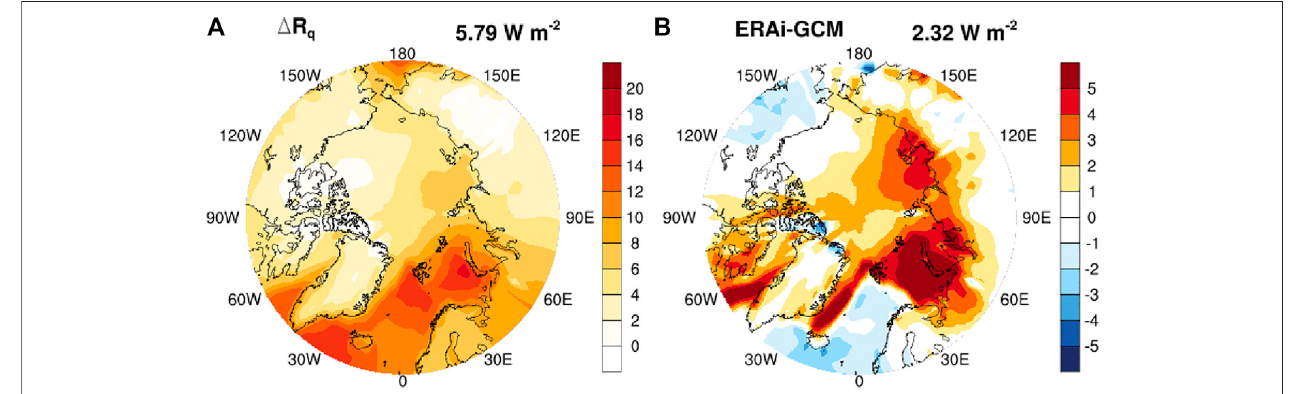
FIGURE4| Clear-skywatervaporfeedbackbiasduetokernelbias. (A) Like Figure2B ,butusingthekernelscomputedfromdifferentatmosphericpro fi les(Huang et al., 2017); (B) Bias compared to Figure 2B .